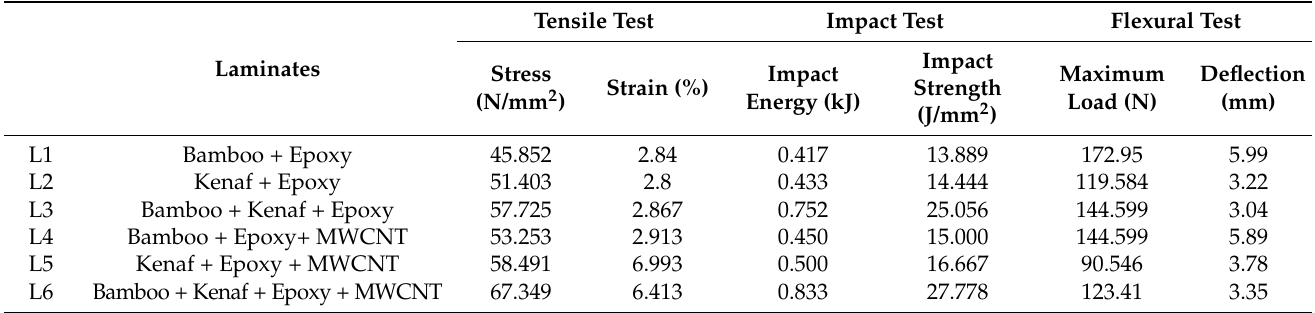
Table 5. Summary of mechanical properties of composites fabricated in the present